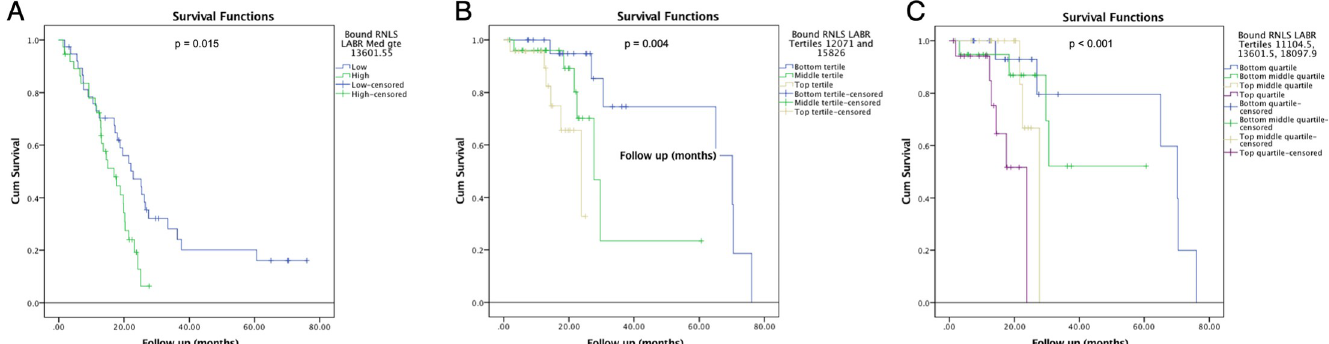
Fig 5. High plasma RNLS levels are associated with worse survival in patients with LA/BR PDAC. (A) When RNLS is cut by median, (B) by tertiles, and (C) by quartiles.